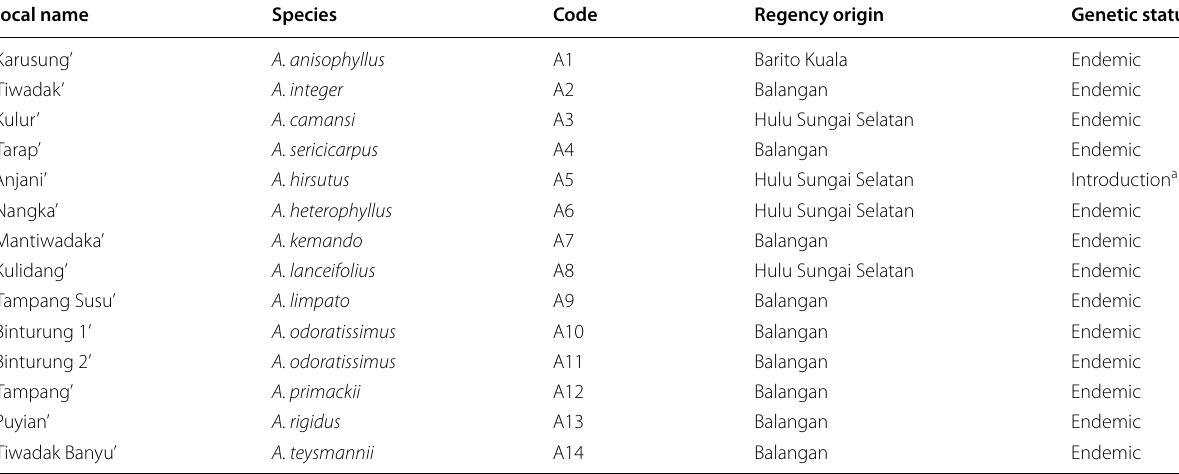
Table 1 Breadfruit species ( Artocarpus spp.) used in the study, including their origin and genetic